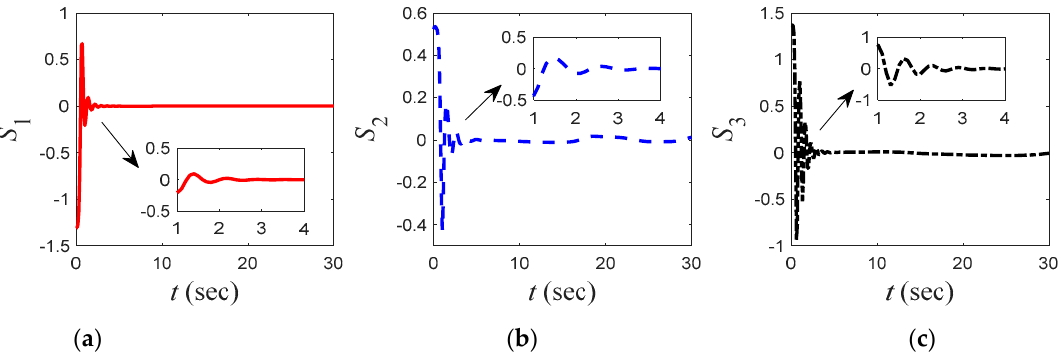
Figure 8. ( a ) The first value of the sliding manifold; ( b ) The second value of the sliding manifold; ( c ) The third value of the sliding manifold.